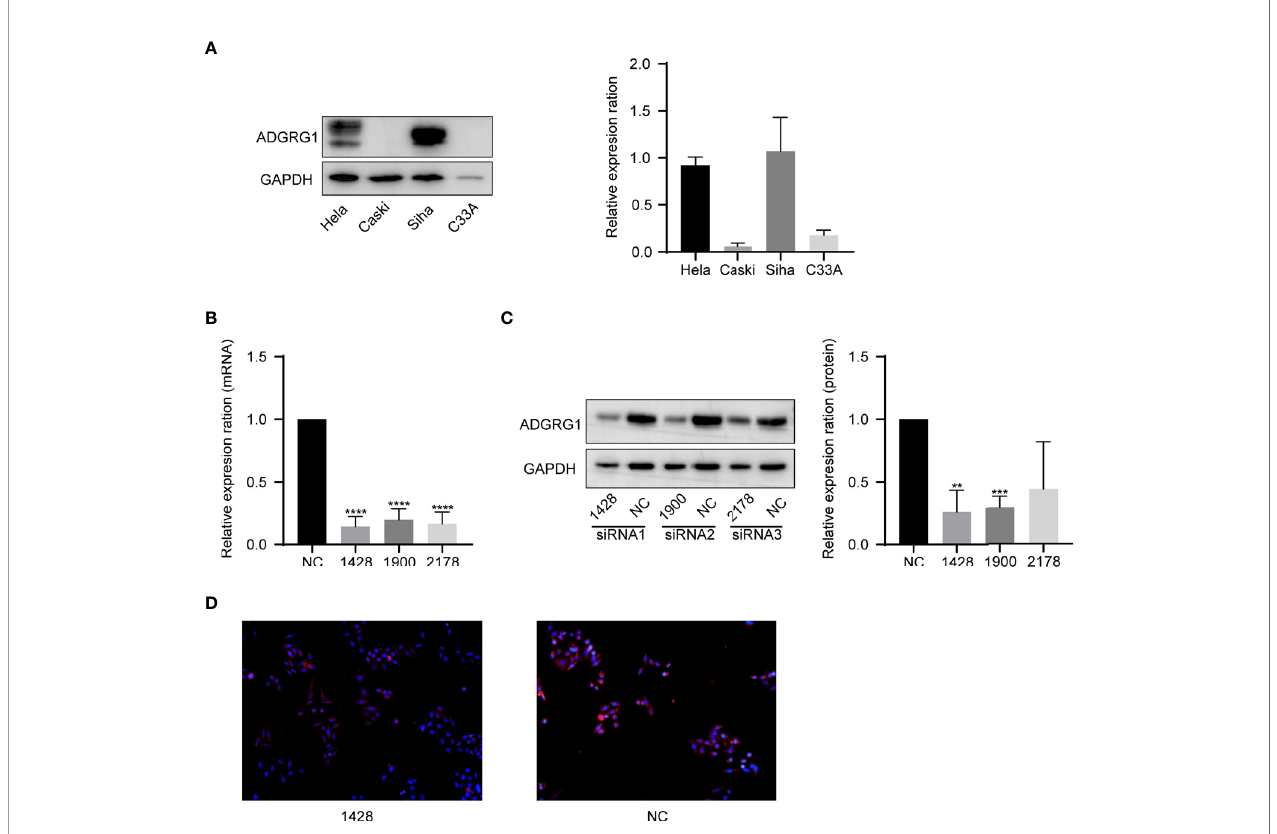
FIGURE 5 | ADGRG1 expression in cell lines and construction of ADGRG knockdown cell line. (A) ADGRG1 protein expression in Hela, Siha, Caski, C33A by western blotting. (B, C) Expression of ADGRG1 was detected by qRT PCR and western blotting in Siha transfected with siRNA targeting GPR56 (si-1428, si-1900,si-2178) and negative control (si NC) (**P < 0.01, ***P < 0.001, ****P < 0.0001). (D) ADGRG1 knockdown effect shown by immuno fl uorescent images (magni fi cations,